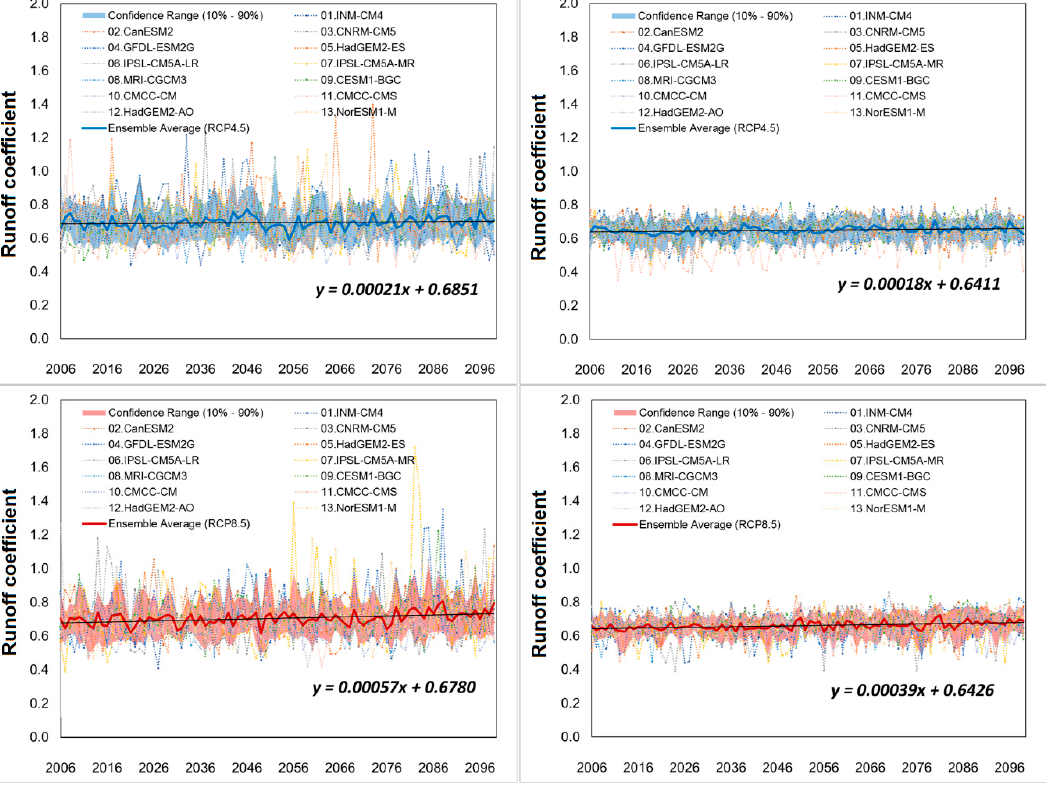
Figure 5. Trend of the runoff coefficients in the dry ( left ) and the wet ( right ) seasons in RCP 4.5 (blue) and RCP 8.5 (red). The bold lines show the ensemble averages, and the shaded areas show the confidence range (10%–90%) of the value of the total runoff coefficient averaged for 109 subbasins for each year of the period 2006–2009. The black lines show the linear regression, and the dash-dotted lines show 13 single-model estimations of the total runoff coefficient averaged for 109 subbasins for each year.